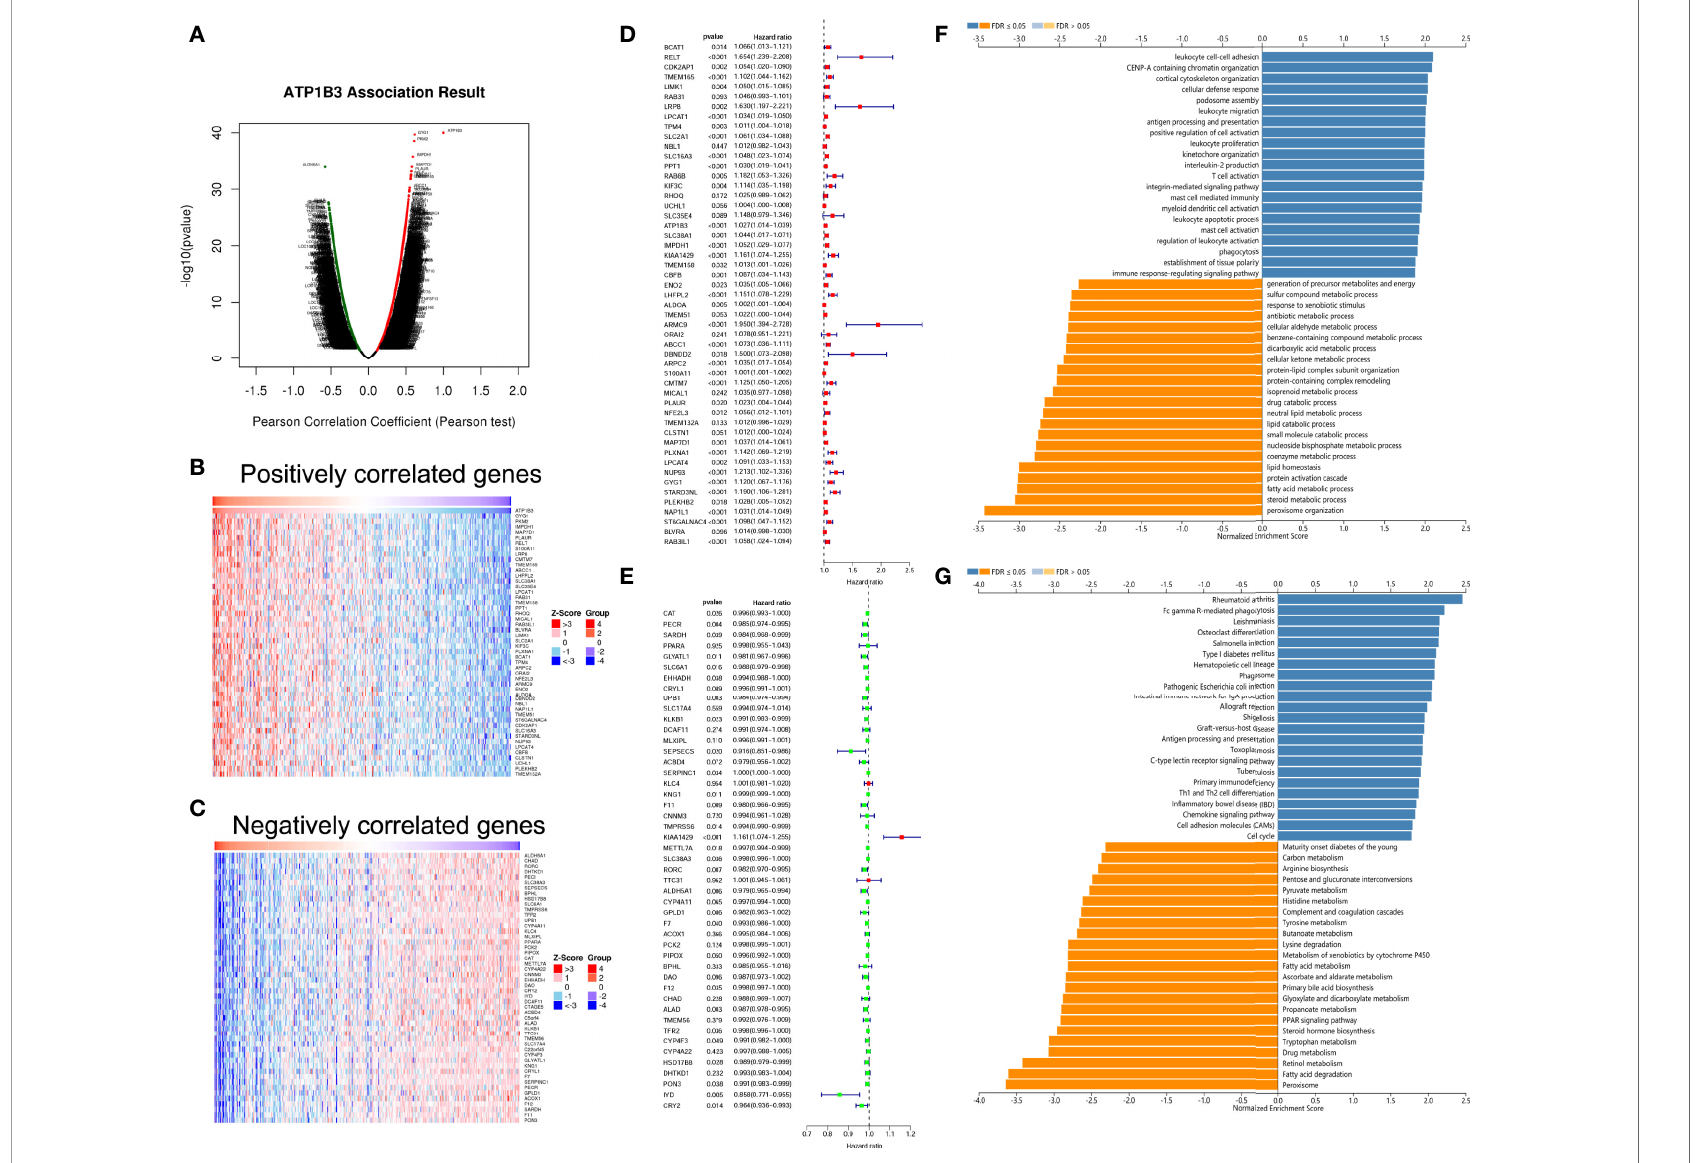
FIGURE 4 | ATP1B3 co-expression genes in HCC using the LinkedOmics. (A) The volcano plot of ATP1B3 co-expression genes. Heat maps revealed the top 50 positively (B) and negatively (C) co-expressed genes of ATP1B3 in HCC. Cox analysis revealed the prognosis of 50 positively (D) and negatively (E) co-expressed genes of ATP1B3 in HCC. The GO enrichment (F) and KEGG pathways (G) of